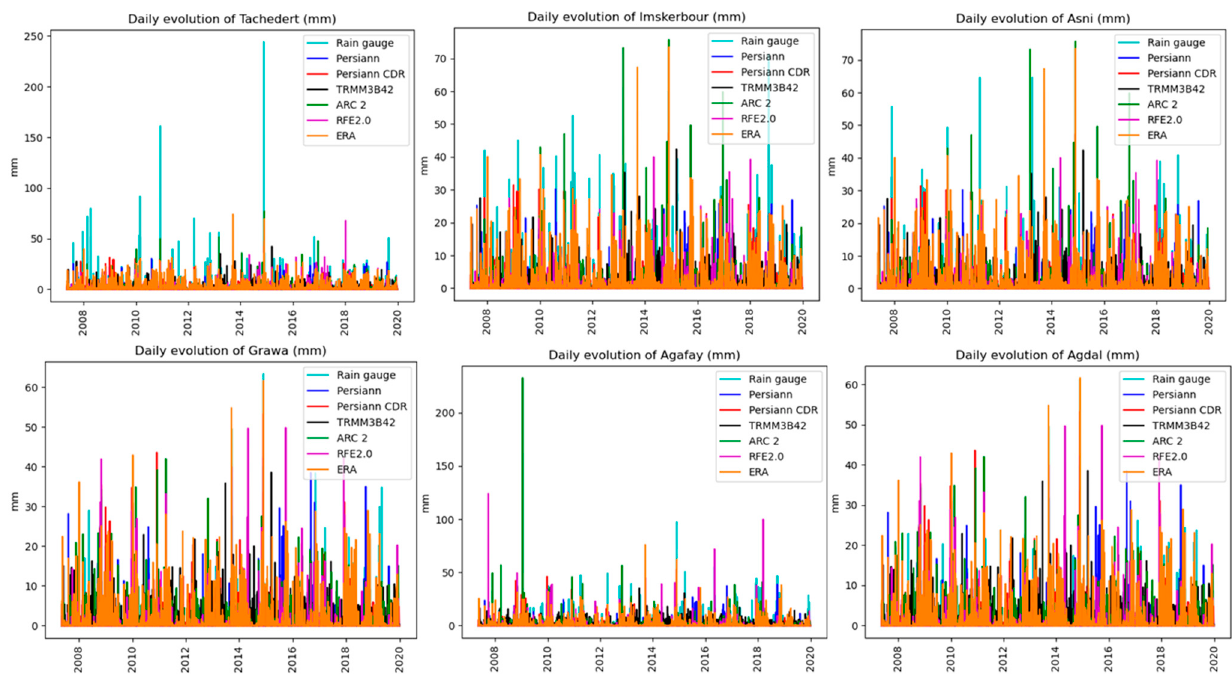
Figure 4. Temporal evolution of daily rainfall rates (mm) for each weather station and corresponding satellite pixels.